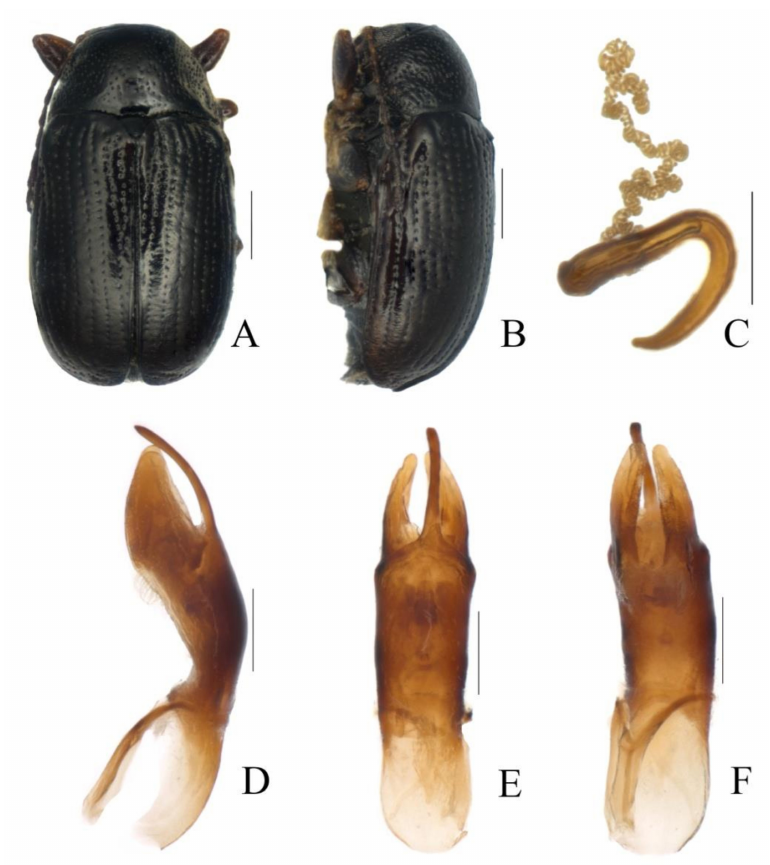
Figure 29. Cryptocephalus ( Burlinius ) pusus Schöller, 2009: ( A ) habitus; ( B ) lateral view of habitus; ( C ) spermatheca; ( D ) lateral view of aedeagus; ( E ) dorsal view of aedeagus; ( F ) ventral view of aedeagus (Scale bars: ( A , B ) = 0.5 mm, ( C – F ) = 0.2 mm) (( A , B , D – F ): paratype, male; ( C ): paratype, female; both from